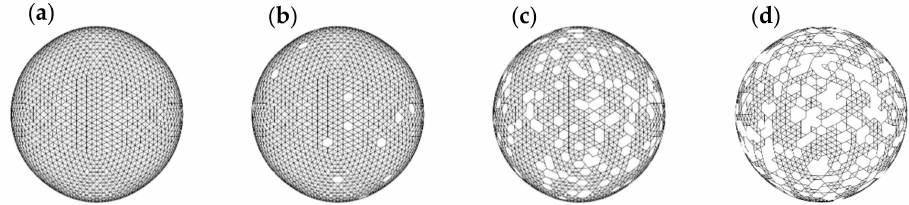
Figure 8. The cytoskeletal spectrin network having ( a ) 0%, ( b ) 1%, ( c ) 10% and ( d ) 25% of defective vertical interactions ( A Vertical ) at randomly selected actin junctional